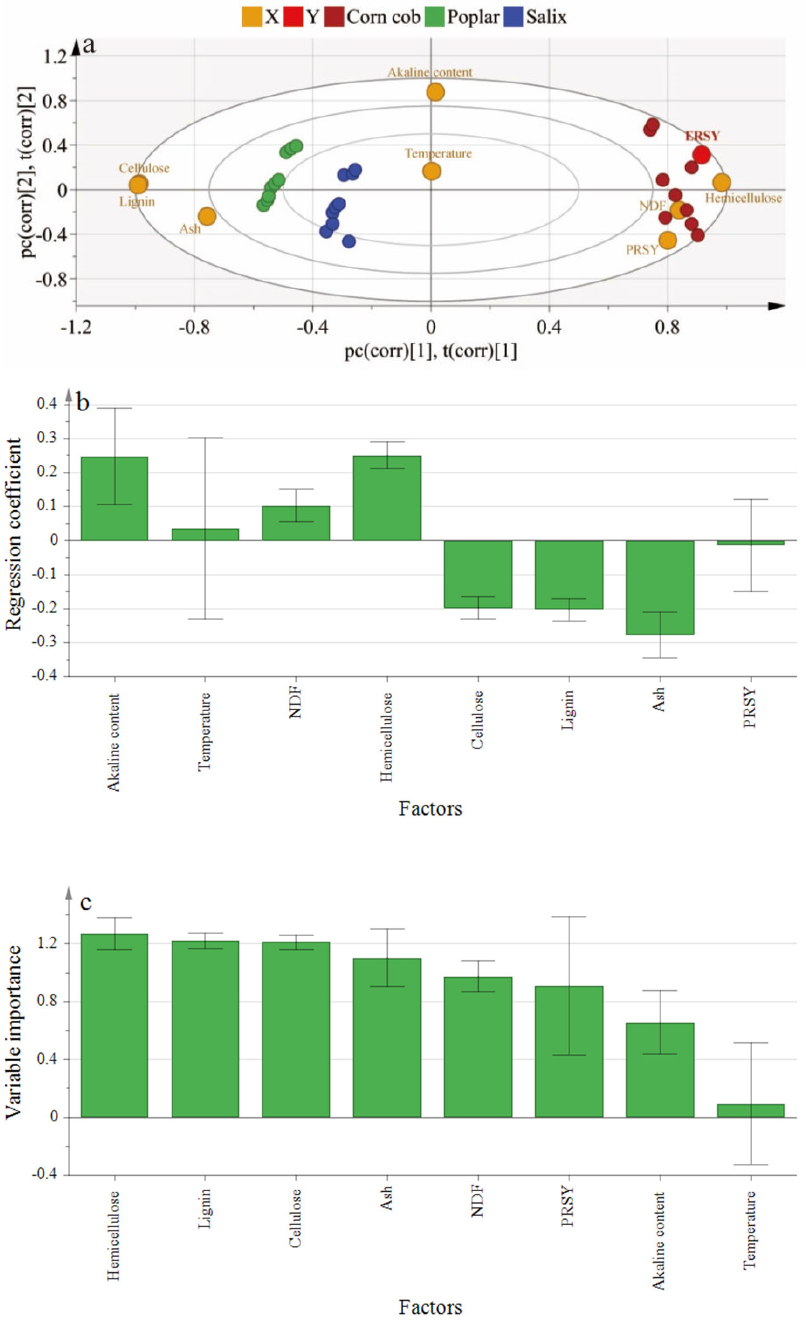
Figure 3. PLS model 2 analysis for the alkaline pretreatment followed by enzymolysis. ( a ) Biplot. ( b ) Regression coefficients of X variables on the Y variable. ( c ) Importance of X variables on the Y variables for the projection.